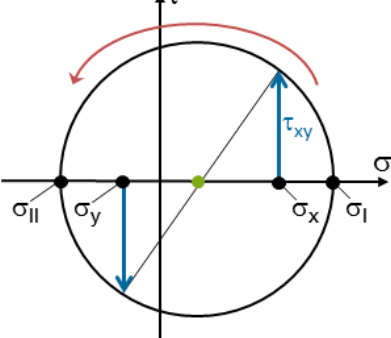
Figure 4: Mohr-circle, which does not change its shape, but rotates constantly: 1 